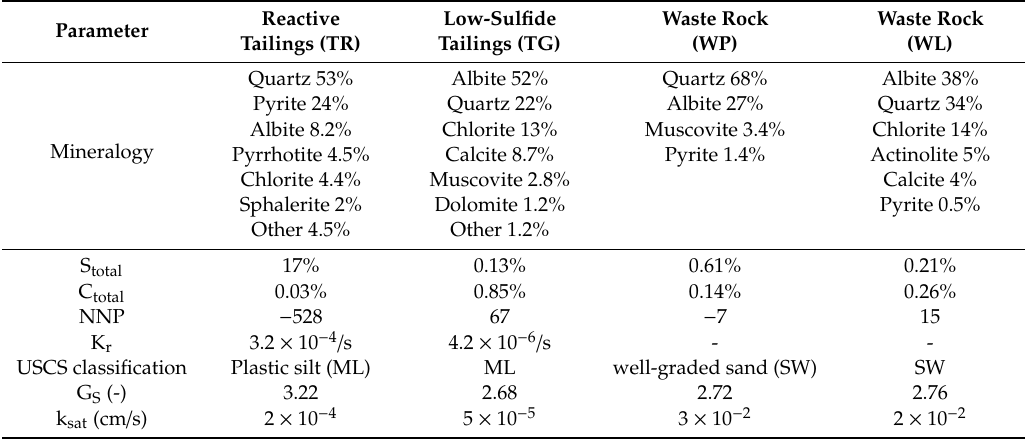
Table 1. Selected material